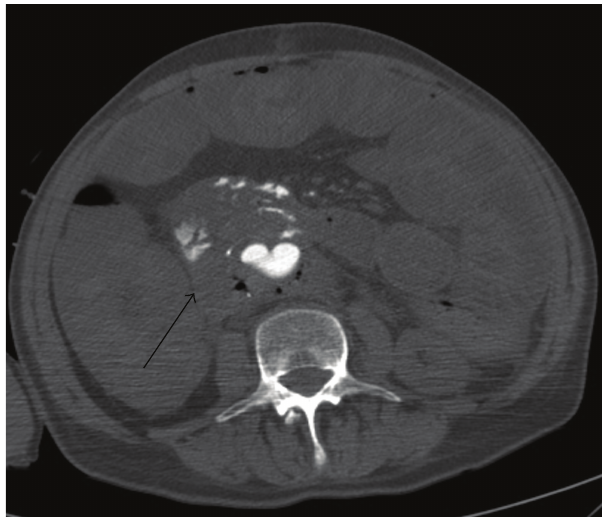
Figure 1: Axial contrast-enhanced CT scan of AEF.